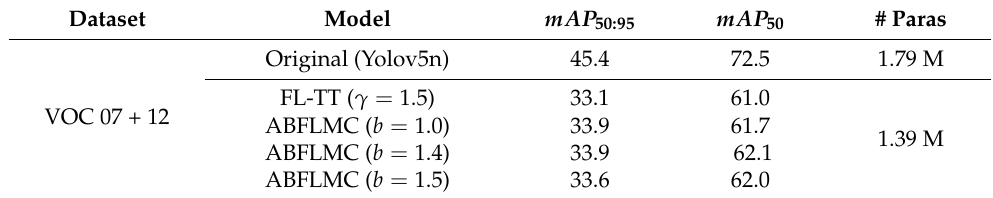
Table 1. Ablation Study under Different Bias in VOC.